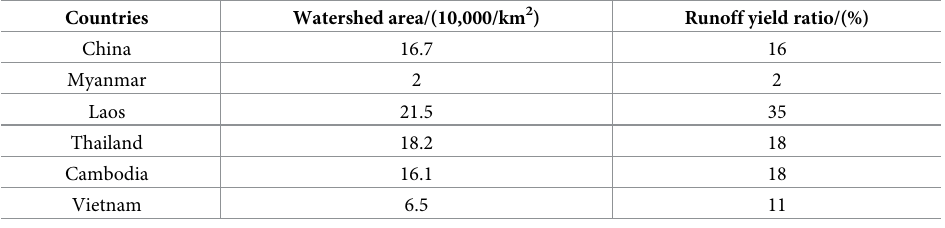
Table 1. Watershed area and corresponding runoff yield ratio of the Lancang-Mekong River Basin countries.